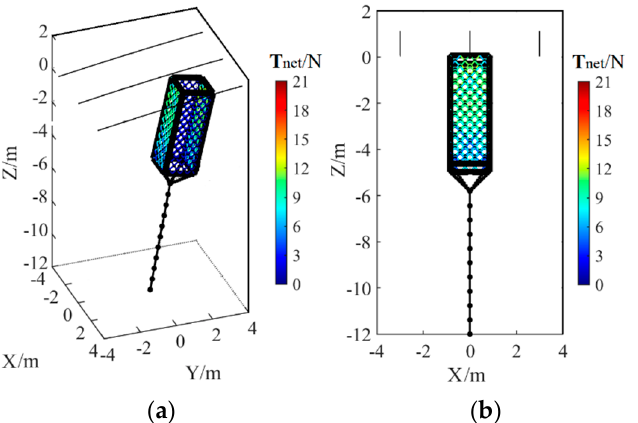
Figure 8. The motion state of the floating reef and the force distribution of fishing net at the maximum pitching angle. ( a ) 3D view. ( b ) Front view.